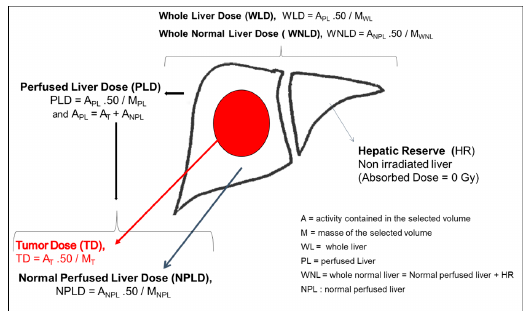
Figure 1. Example of dosimetry parameters for a treatment. A = activity contained in the selected volume (ex: A PL = Activity contained in the Perfused Liver); M= Mass of the selected volume; HR = Hepatic Reserve; NPL = Normal Perfused Liver; NPLD = Normal Perfused Liver Dose; PL= Perfused liver; PLD = Perfused Liver Dose; T = Tumor ; TD = Tumor Dose; WL = Whole Liver; WLD = Whole Liver Dose; WNL= Whole Normal Liver; WNPLD = Whole Normal Perfused Liver Dose.